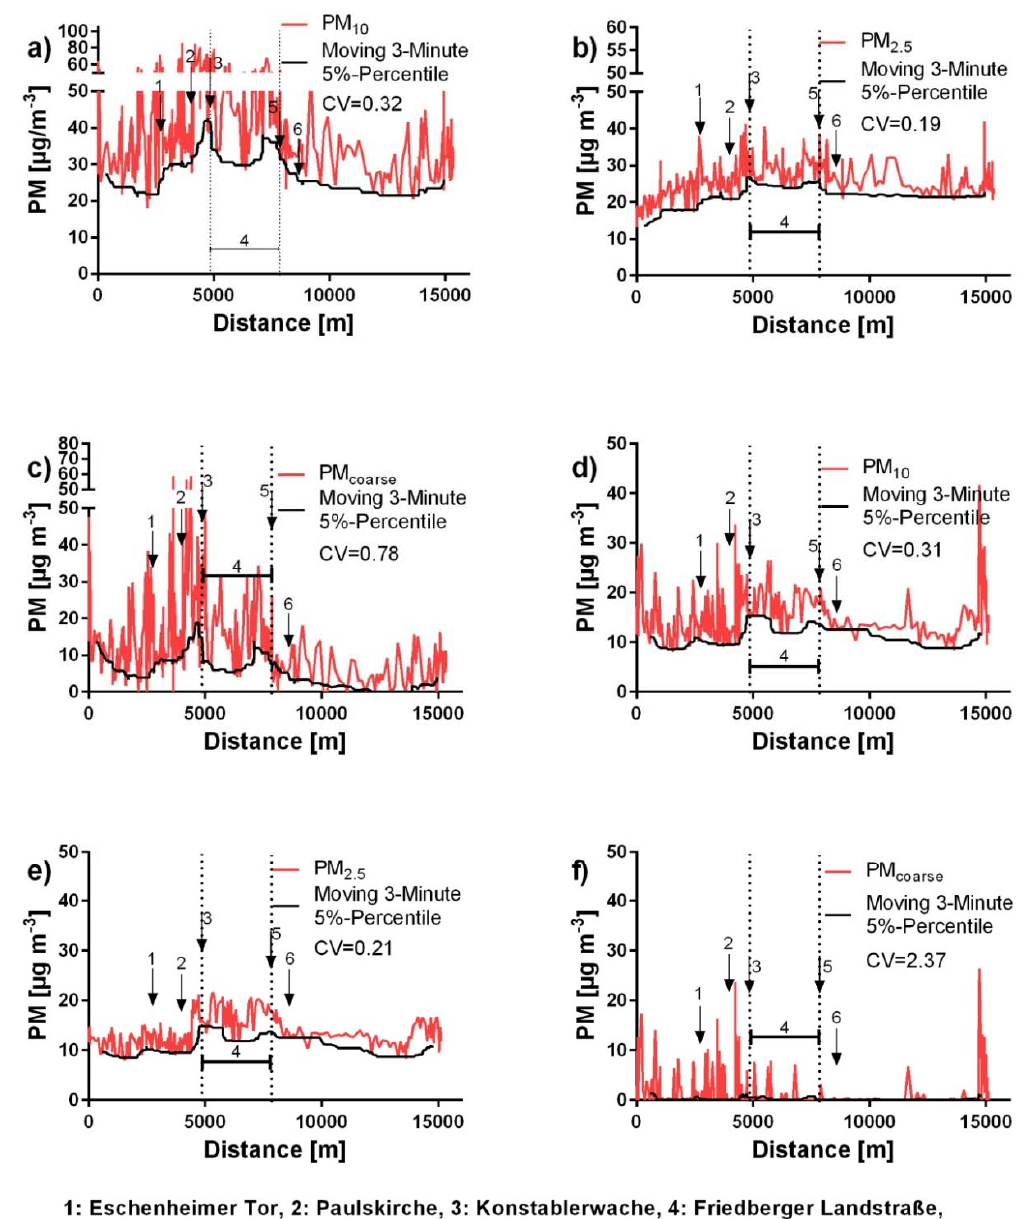
Figure 5. Representative in-cabin PM concentrations with corresponding background concentrations for PM 10 , PM 2.5 , and PM coarse on 01-06-16. ( a – c ) Measured while driving with an opened window; ( d – f ) measured while driving with a closed window. Geographical positions are marked by the numbers, 1 – 6.